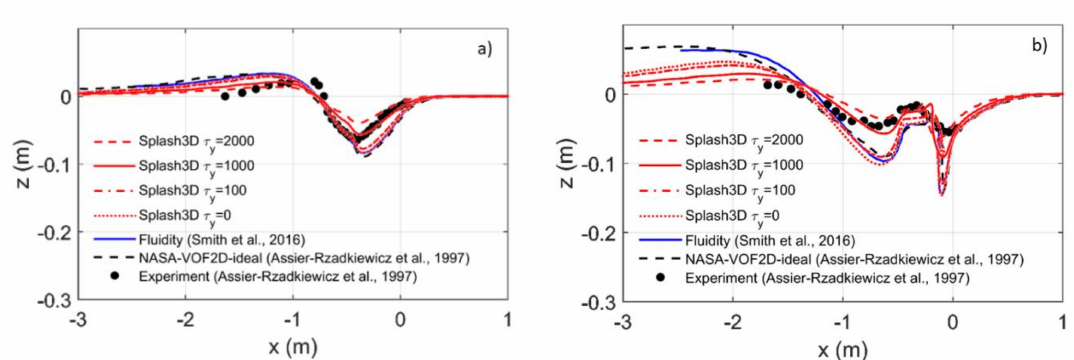
Figure 8. The comparison of free-surface profiles for di ff erent yield stress τ y in the Bingham model. Di ff erent lines indicate di ff erent values of inline-formula > τ y , the dots denote the experimental results from Assier Rzadkiewicz at: ( a ) t = 0.4 s and ( b ) t = 0.8 s.